Question: Sum up the contents of this chart in one sentence.
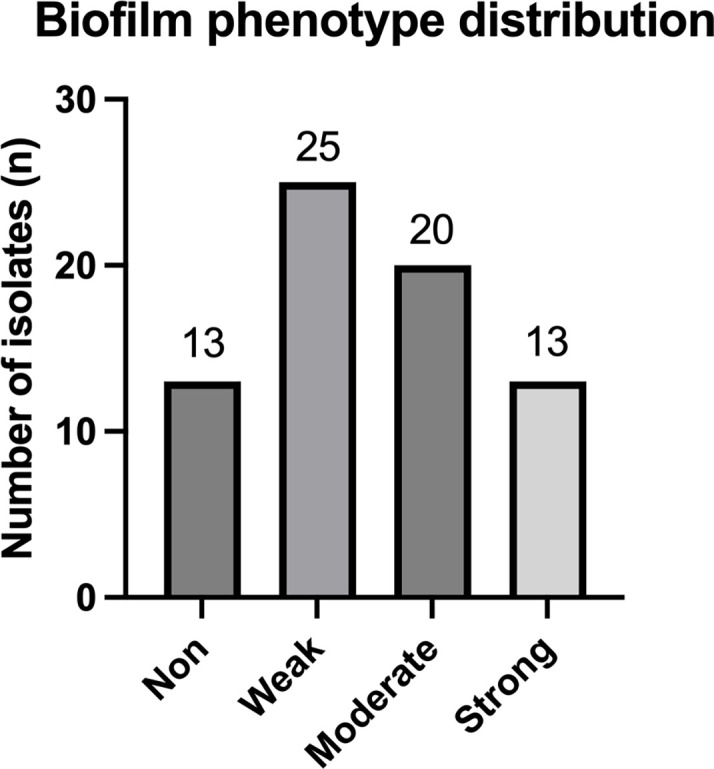
Answer: Prevalence of fimH and secretion system-associated genes among UPEC clinical isolates ( n = 71) and the reference strains